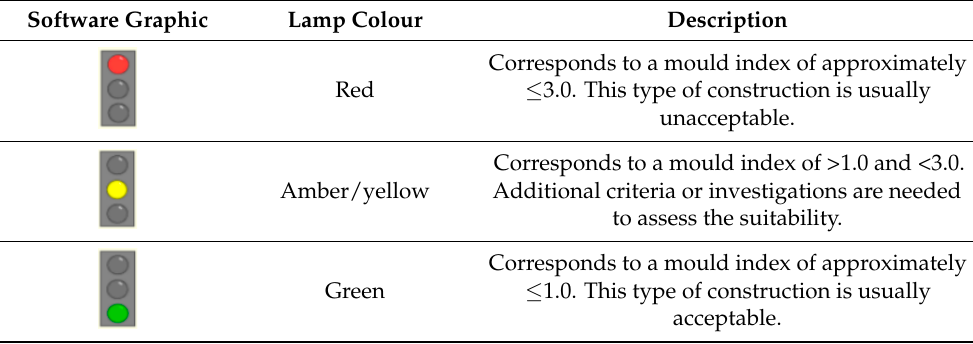
Table 2. Mould growth risk calculation results [13].